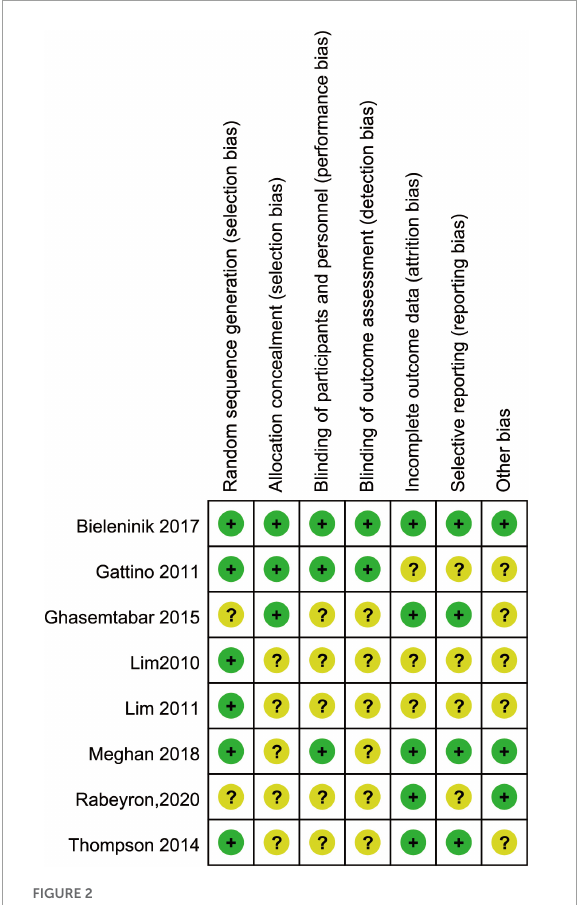
FIGURE2 Risk of bias in the included